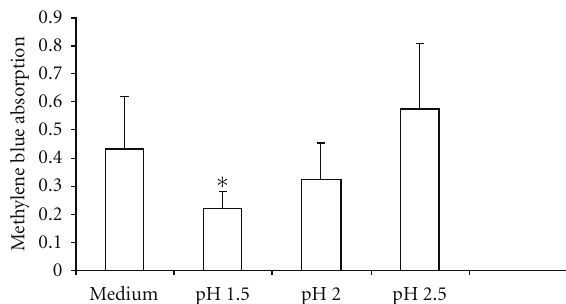
Figure 2: pH dependence of 16-HBE cell survival, as measured by methylene blue absorption. ∗ Exposure of cells to medium with pH 1.5 for 5 minutes resulted in significantly less cell proliferation after 20 hours of incubation compared to exposure to pH 2.5 (mean absorption 0.22 versus 0.57; P = 0 . 03, n = 3). pH of control medium was 7.9. Histograms represent the means and the bars the SEM.